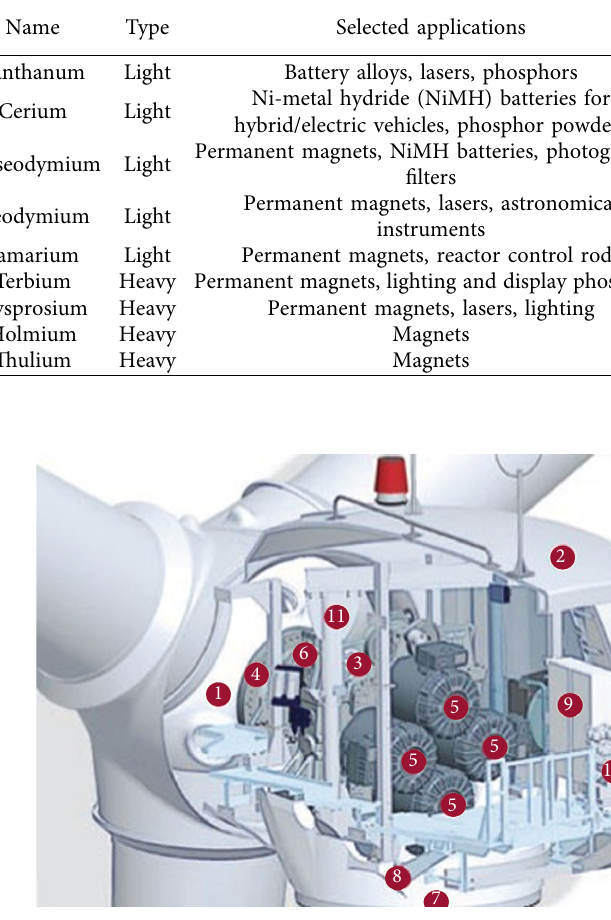
Figure 4: Exploded view of a typical 2.5MW clipper wind turbine showing the position of four permanent magnet generators (5) [25].